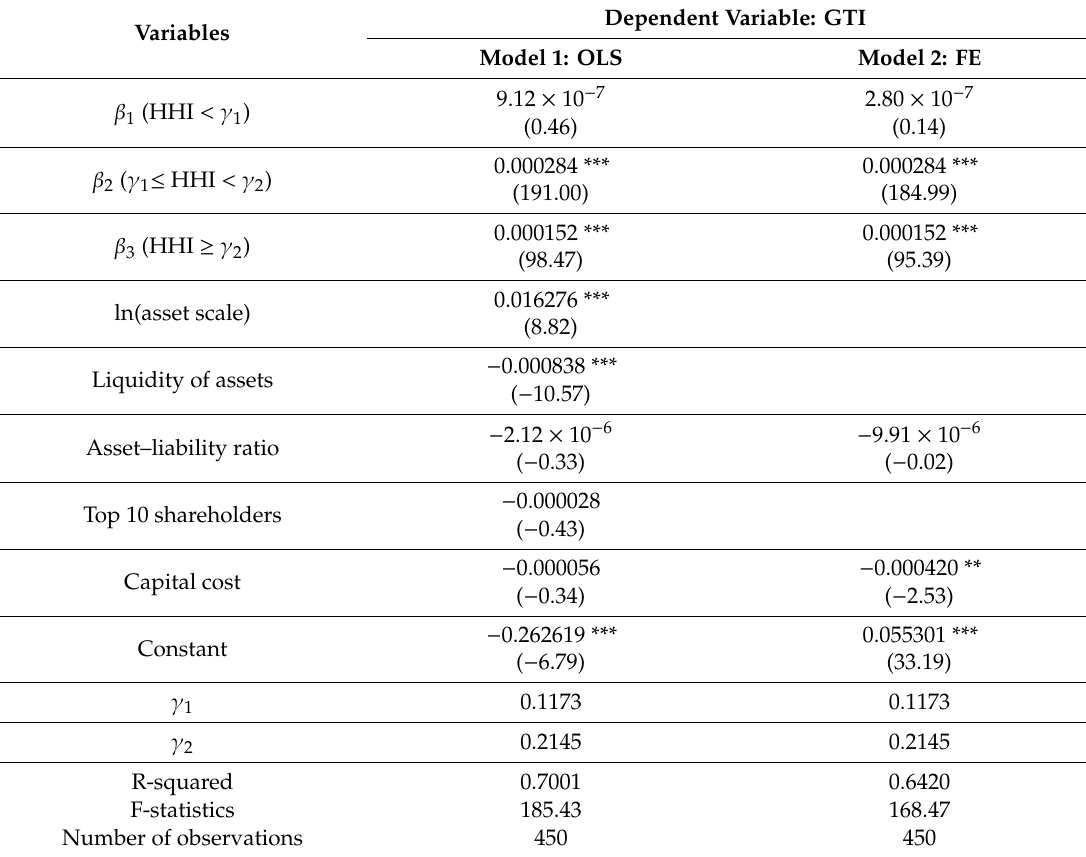
Table 8. Threshold regression of labor cost impact on green technological